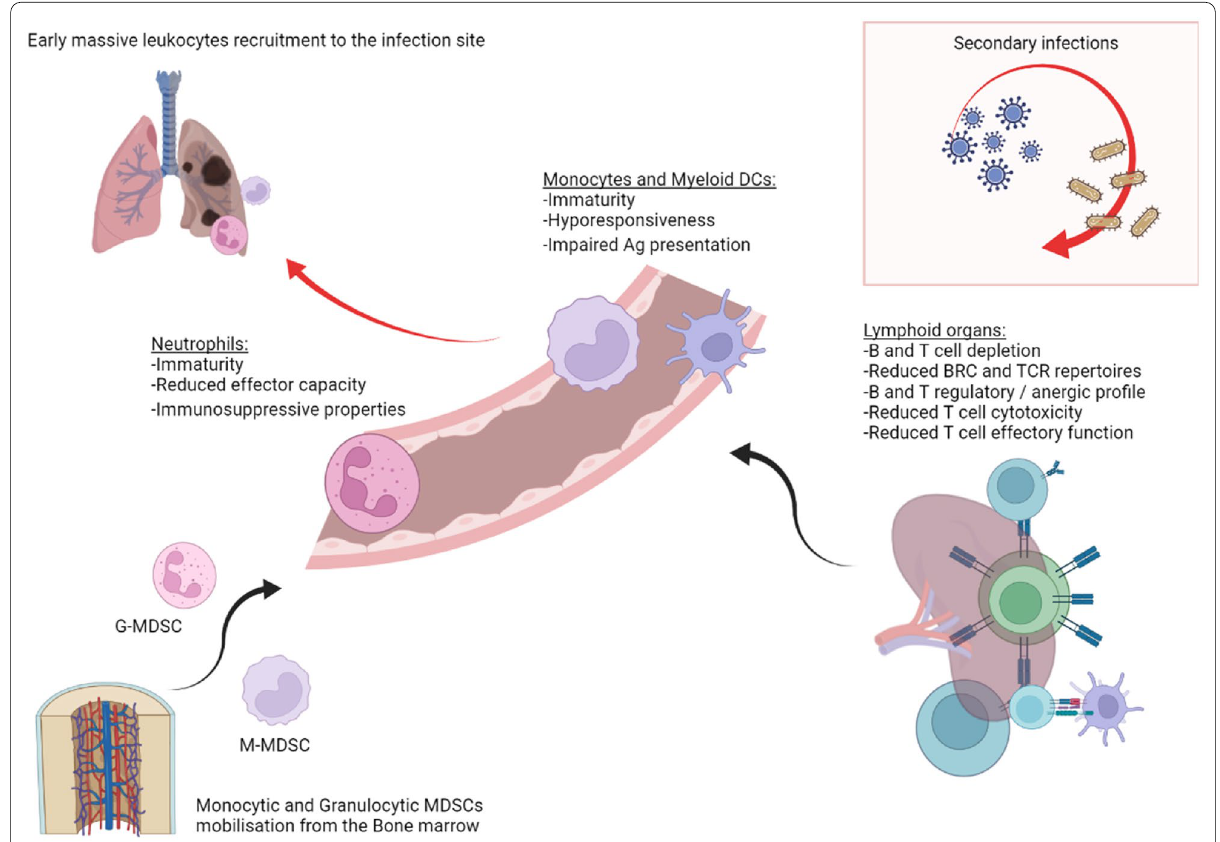
Fig. 3 Putative mechanisms of ICU‑acquired immune